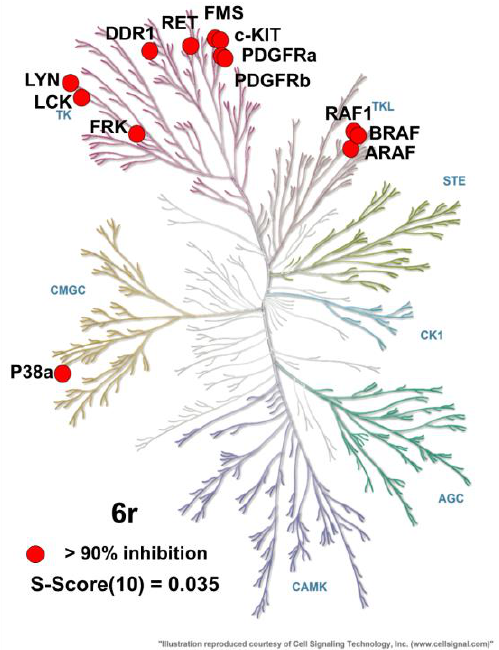
Figure 3. Kinase panel profiling of 6r . Kinases that are more than 90% inhibited are represented by red circles. Illustration is provided by Cell Signaling Technology, Inc. (www.cellsignal.com, accessed on 3 November 2022) [41].